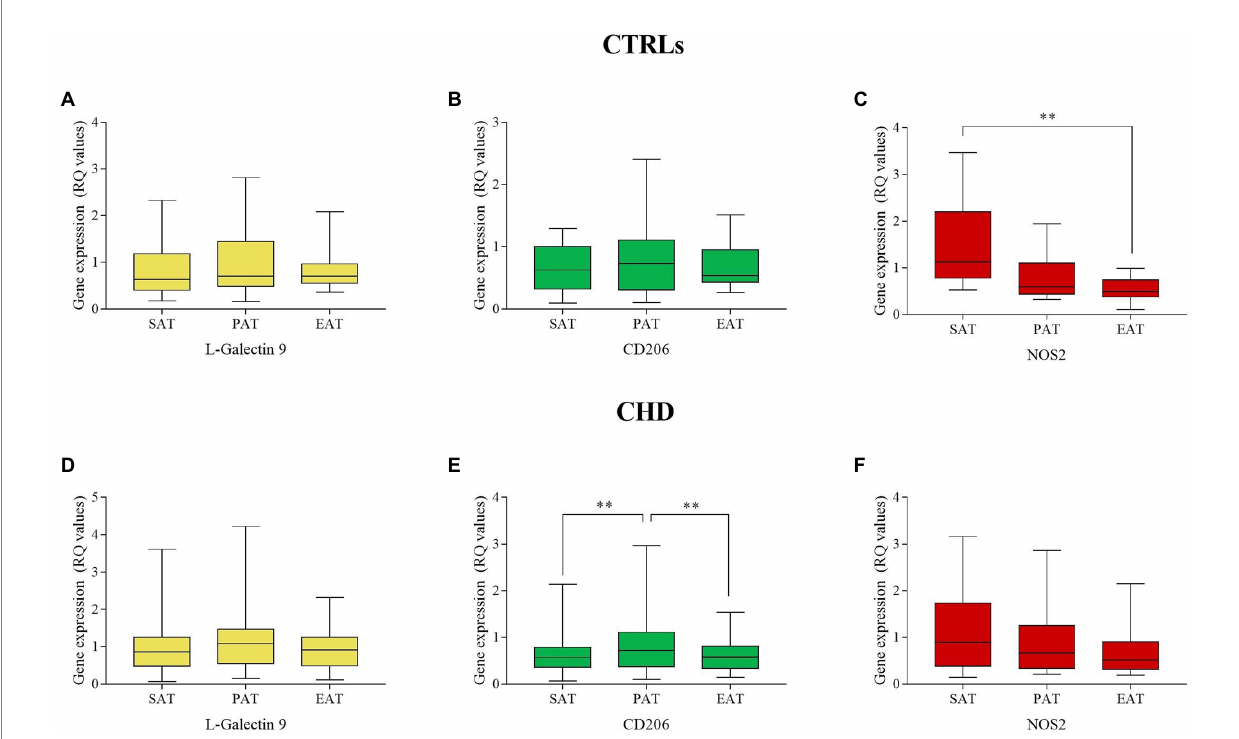
FIGURE 1 Gene expression of L-Gal 9, CD206, and NOS2 in SAT, PAT, and EAT compartments. Data are reported as RQ values and box plots indicate the median values, 25th and 75th percentiles, while error bars report 10th and 90th percentiles. Gene expression in AT compartments was evaluated through the